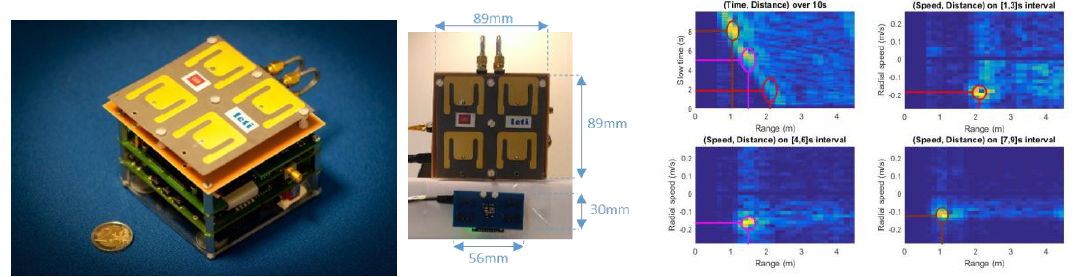
Figure 11. Ultra-wideband radar prototype ( left , middle ) and its response over time (3 snapshots) ( right